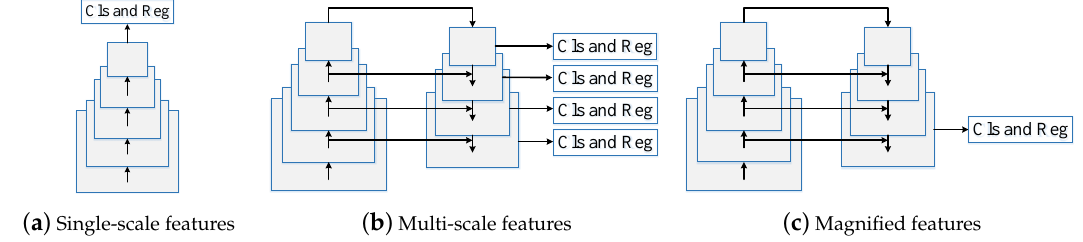
Figure 6. ( a ) The single-scale features are used to perform classification and regression (Cls and Reg). ( b ) The multi-scale features are used to perform classification and regression. ( c ) The magnified features are used to perform classification and